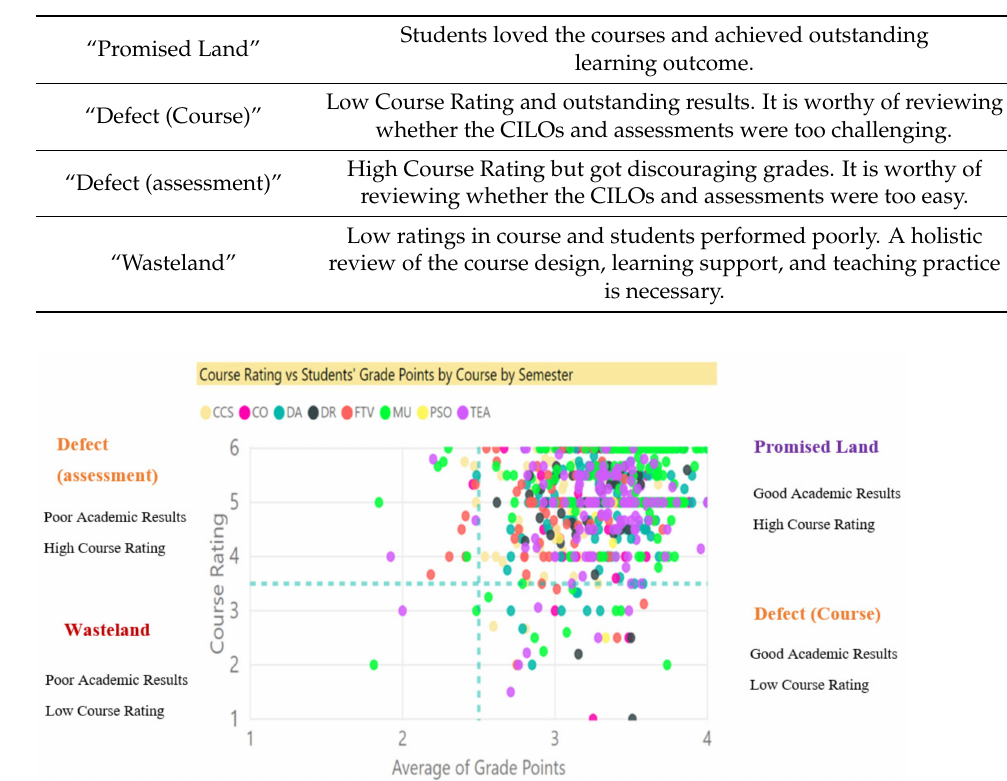
Figure 16. Course Grade Point–Student Effort Matrix. Note: (1) In the visual, each data point represents the average “Student Effort” rating given by students, and students’ grade for a particular course. Table 6. The definition of the Course Average Grade Point–Course Rating Matrix.